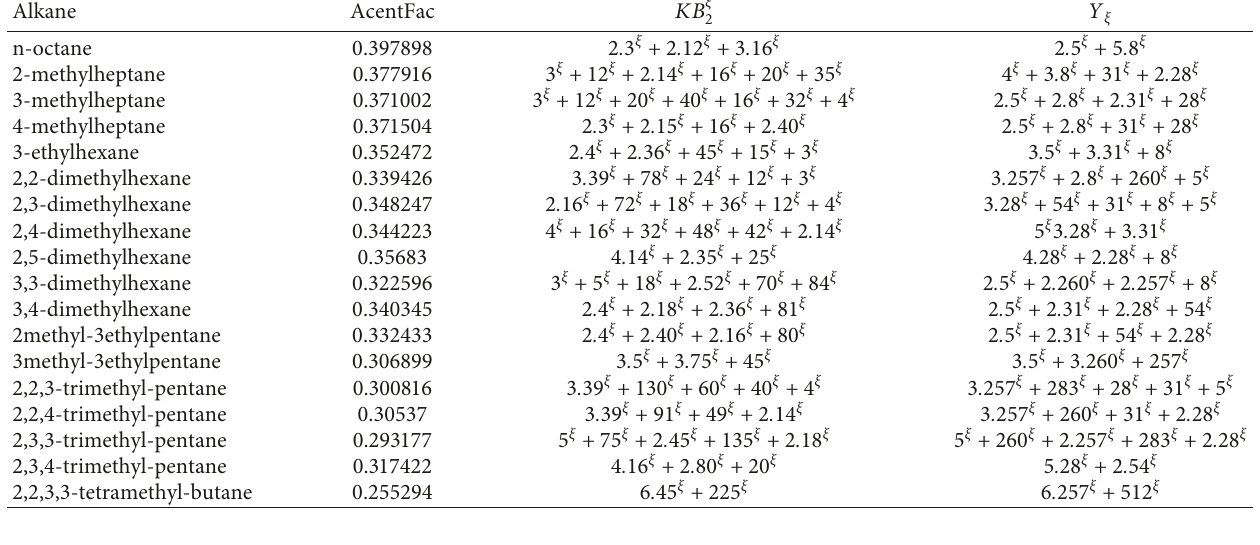
Table 8: Experimental values of acentric factor and the corresponding values of generalized form of second Kulli–Basava index and generalized power-sum-connectivity index of octane